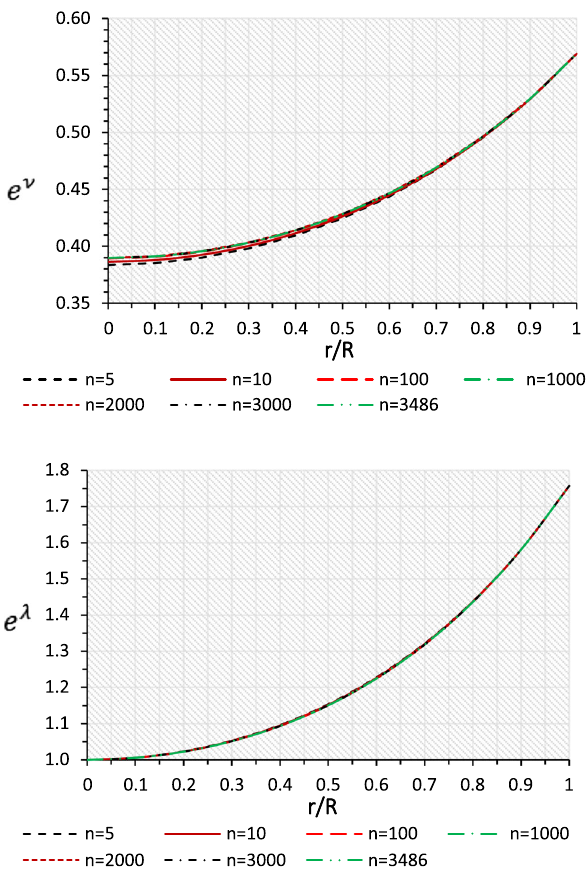
Fig. 3 Behaviourofradialpressure p r ( r ) andtangentialpressure p t ( r ) vs. radial coordinate r / R with different values of n for LMC X −